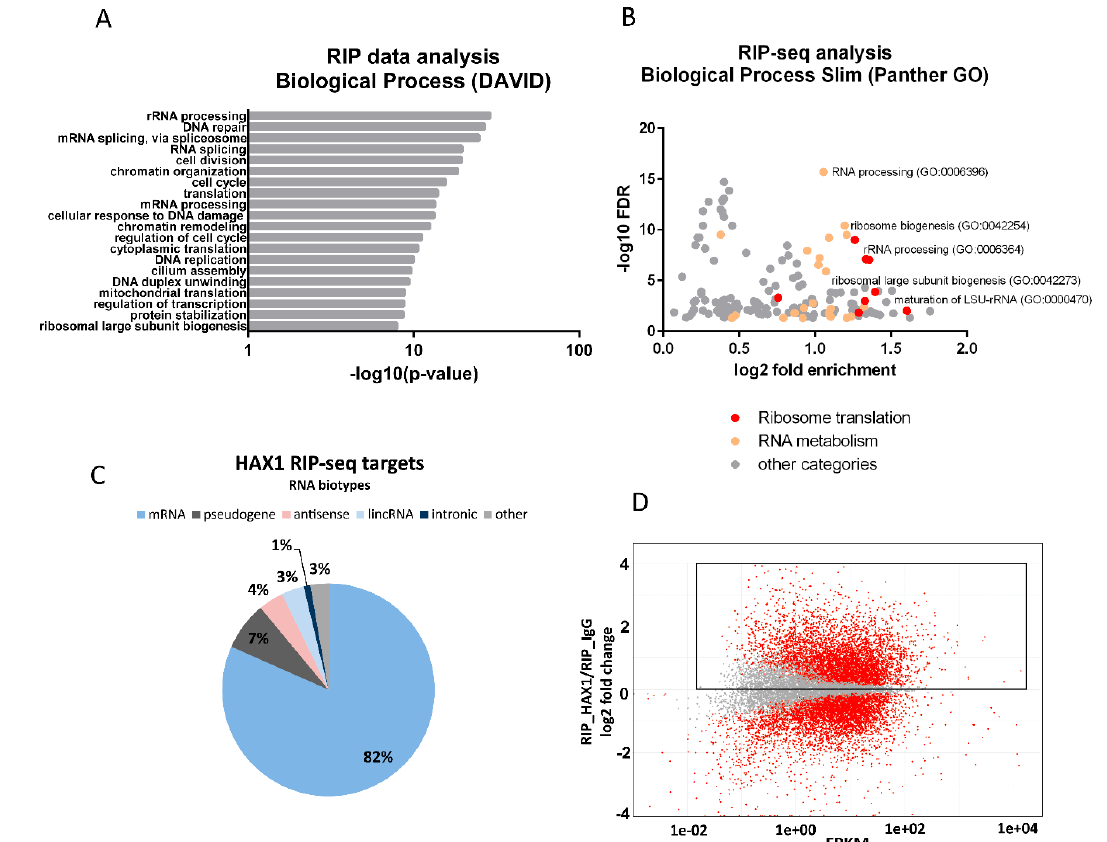
Figure 2. Identification of HAX1-associated RNA targets by RIP-seq analysis in HL-60 cells. ( A ) Functional annotation enrichment of HAX1 target genes. Enriched gene ontology terms (DAVID: Biological Process) presented in bar plot, the length of each bar corresponds to statistical significance of the enrichment (-log10 p -value). The top twenty terms are presented. ( B ) Enriched Biological Process terms (Panther GO) plotted with fold enrichment (log2) against False Discovery Rate (- log10). The most reliable results are in the upper right corner. Categories associated with ribosome biogenesis, rRNA processing, and translation are marked red. Categories associated with RNA metabolism (other than rRNA) are marked light orange. Detailed description of GO terms in Supplementary File